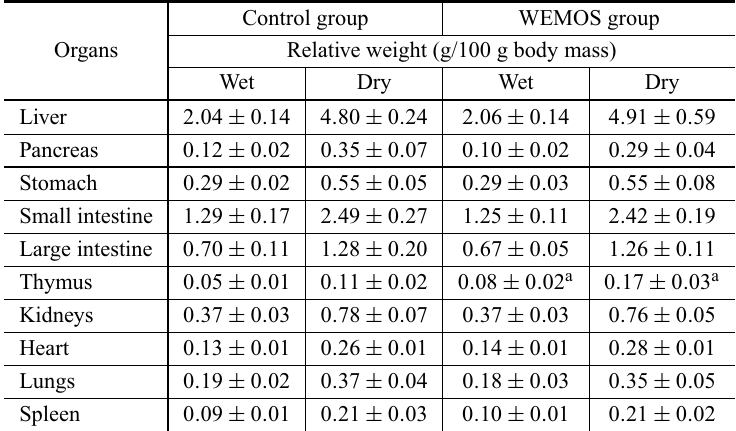
Organ relative weights of rats treated with water extract of Moringa oleifera seeds (WEMOS) ad libitum during 30 days. Control group received tap water. Control group WEMOS group Organs Relative weight (g/100 g body mass) Wet Dry Wet Dry Liver 2 . 04 ± 0 . 14 4 . 80 ± 0 . 24 2 . 06 ± 0 . 14 4 . 91 ± 0 . 59 Pancreas 0 . 12 ± 0 . 02 0 . 35 ± 0 . 07 0 . 10 ± 0 . 02 0 . 29 ± 0 . 04 Stomach 0 . 29 ± 0 . 02 0 . 55 ± 0 . 05 0 . 29 ± 0 . 03 0 . 55 ± 0 . 08 Small intestine 1 . 29 ± 0 . 17 2 . 49 ± 0 . 27 1 . 25 ± 0 . 11 2 . 42 ± 0 . 19 Large intestine 0 . 70 ± 0 . 11 1 . 28 ± 0 . 20 0 . 67 ± 0 . 05 1 . 26 ± 0 . 11 Thymus 0 . 05 ± 0 . 01 0 . 11 ± 0 . 02 0 . 08 ± 0 . 02 a 0 . 17 ± 0 . 03 a Kidneys 0 . 37 ± 0 . 03 0 . 78 ± 0 . 07 0 . 37 ± 0 . 03 0 . 76 ± 0 . 05 Heart 0 . 13 ± 0 . 01 0 . 26 ± 0 . 01 0 . 14 ± 0 . 01 0 . 28 ± 0 . 01 Lungs 0 . 19 ± 0 . 02 0 . 37 ± 0 . 04 0 . 18 ± 0 . 03 0 . 35 ± 0 . 05 Spleen 0 . 09 ± 0 . 01 0 . 21 ± 0 . 03 0 . 10 ± 0 . 01 0 . 21 ± 0 . 02 Values are means ± S.D., n = 10 animals/group. a P < 0 . 05, compared to control by one-way analysis of variance (ANOVA) followed by Newman-Keuls